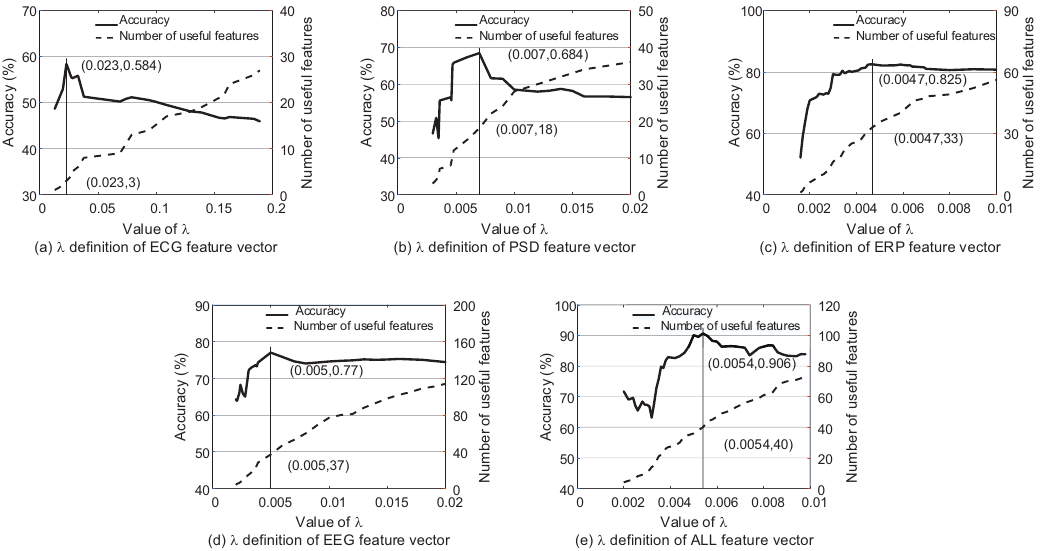
Figure 6. The classification accuracy using the single feature vectors (PSD feature vector, ERP feature vector, ECG feature vector) and fused vectors (EEG feature vector, ALL feature vector) according to λ based on SVM (C = 10 − 3